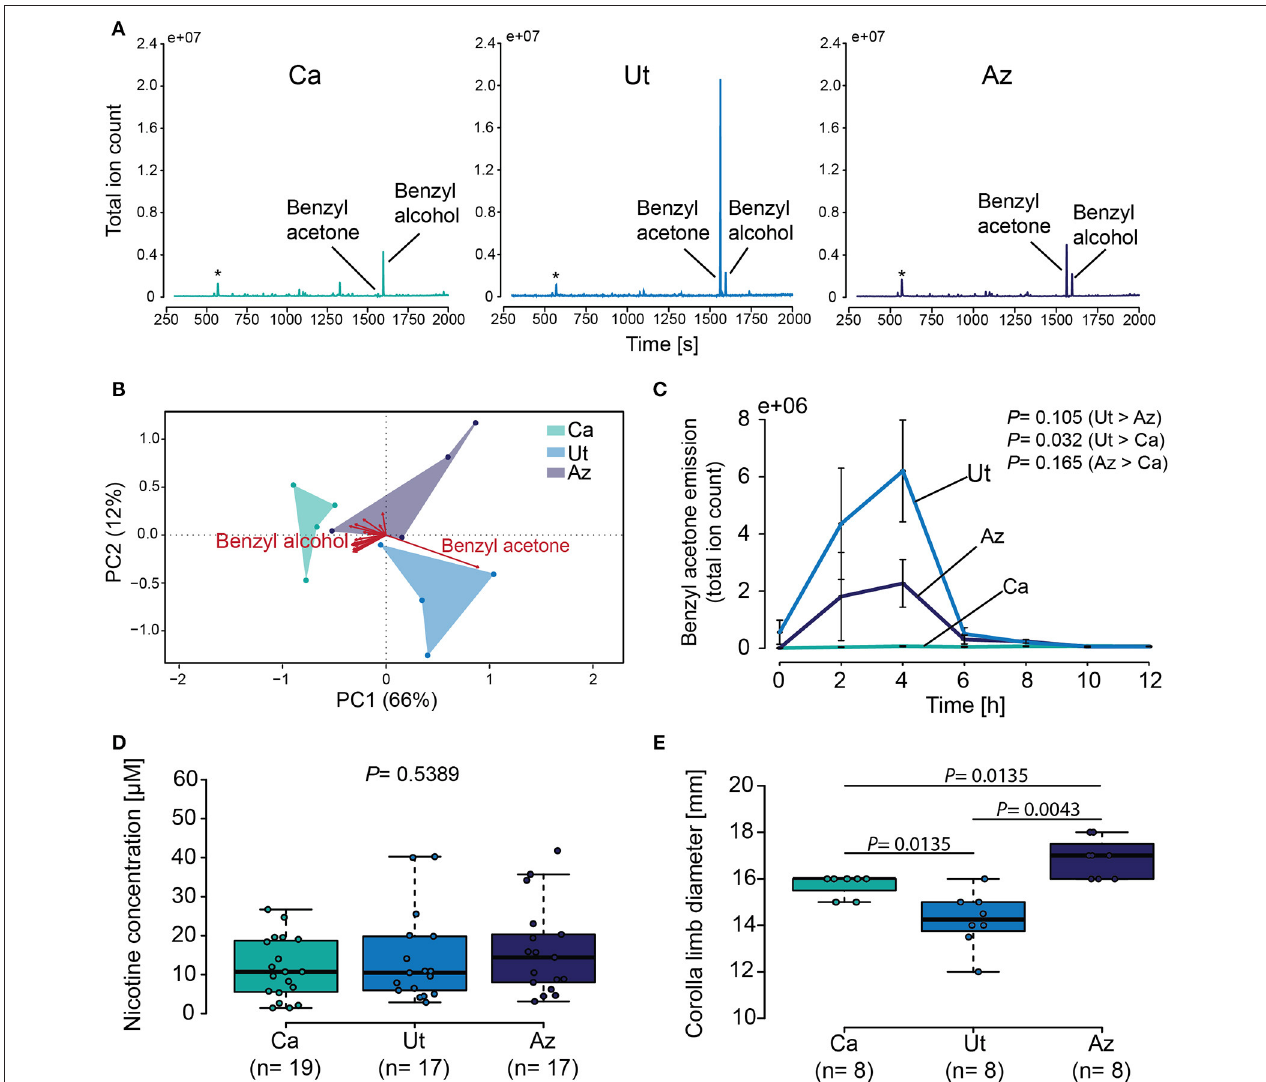
FIGURE 4 | Characterization of the main secondary chemical flower signals and of the flowers visual display. (A) Chromatograms showing flower volatile emissions for plants from the California (Ca), the Utah (Ut) and the Arizona (Az) population from 2 to 4h after sunset. Asterisk indicates siloxane contamination from collection material. (B) Biplot visualizing the loading of all volatiles present in the floral headspaces of the three different N. attenuata populations. (C) Mean ± SEM benzyl acetone emission during 2h trapping intervals for 12h starting at sunset. Samples were trapped using PDMS and measured with a TDU-GC-MS. (D) Nicotine in the floral nectar of the three different plant populations. (E) Boxplot depicting corolla limb diameter. Error bars of the boxplots indicates 1.5 times the interquartile range, boxes depict 1st and 3rd quartiles and dots show individual measurements. GLM with a polynomial distribution on (C) , Kruskal–Wallis test, followed by Holm corrected LSD test in (D,E)